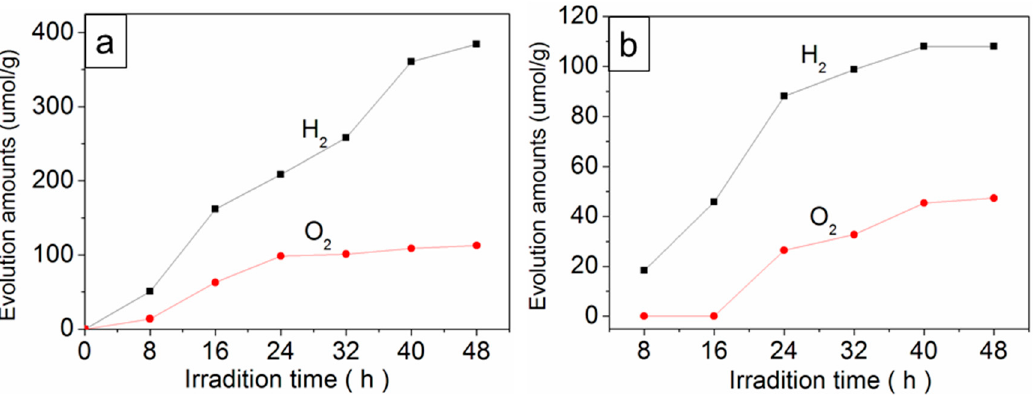
Figure 4. Photocatalytic activity of SrTiO 3 -C950 under full-spectrum light irradiation ( a ) or visible light irradiation ( b ) without sacrificial reagent. No photocatalytic water splitting activity was observed for pristine SrTiO 3 and SrTiO 3 -C300 under the same conditions.